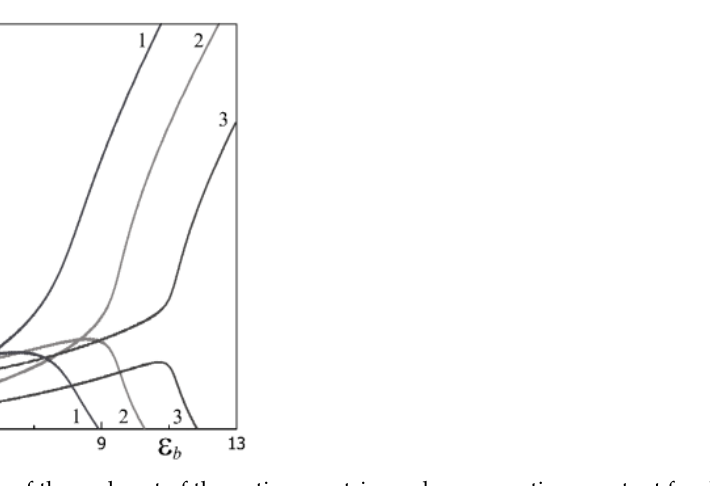
Figure 8. Dependence of the real part of the antisymmetric mode propagation constant for doped graphene on the barrier layer permittivity; d = 30 nm, f = 8.6 THz, µ = 0;0.02;0.03 eV (curves 1–3).